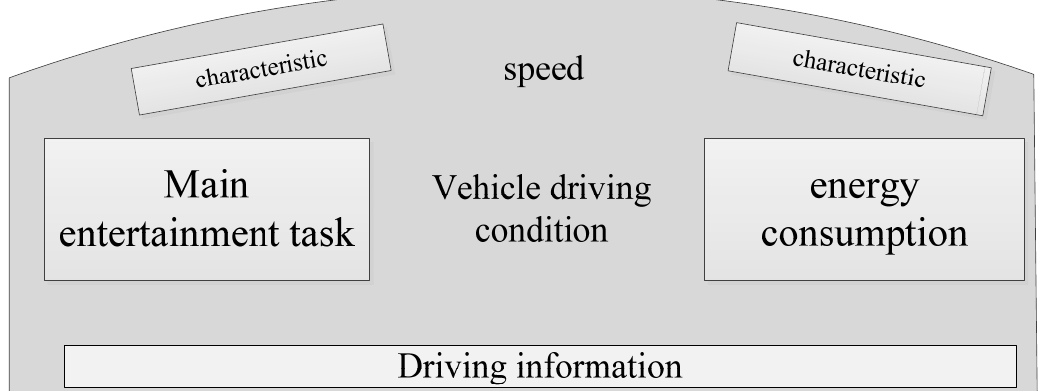
Figure 3. Instrument panel layout.